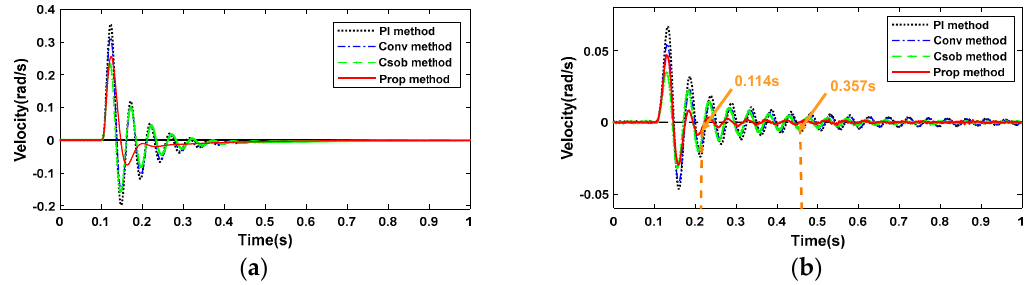
Figure 12. Input disturbance suppression with motor-side controller: ( a ) simulations; ( b ) experiments.